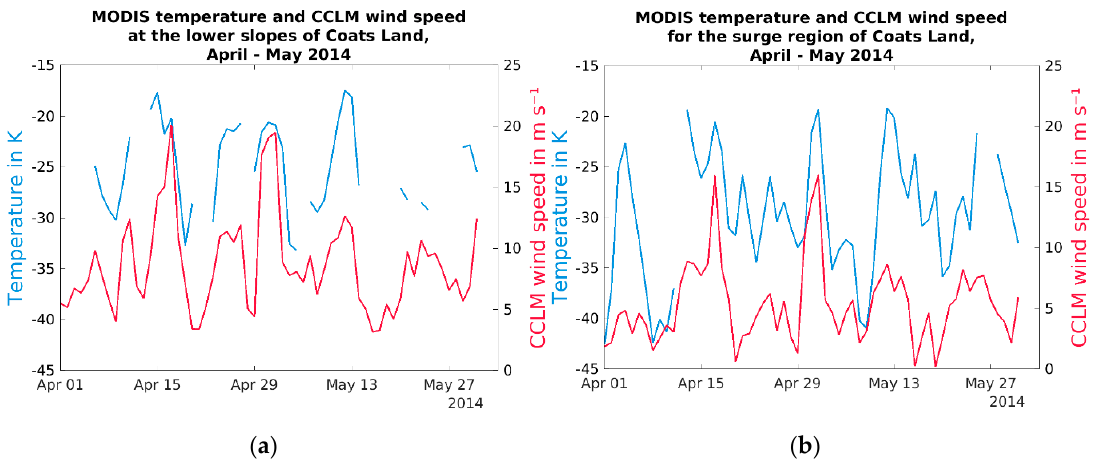
Figure 13. Time series of daily averages of MODIS ice surface temperature (IST) (blue) and CCLM 10 m-wind speed (red) for the slope ( a ) and surge areas ( b ) for April and May 2014. A comparison of simulated IST from CCLM with the MODIS IST (both as daily values) is shown in